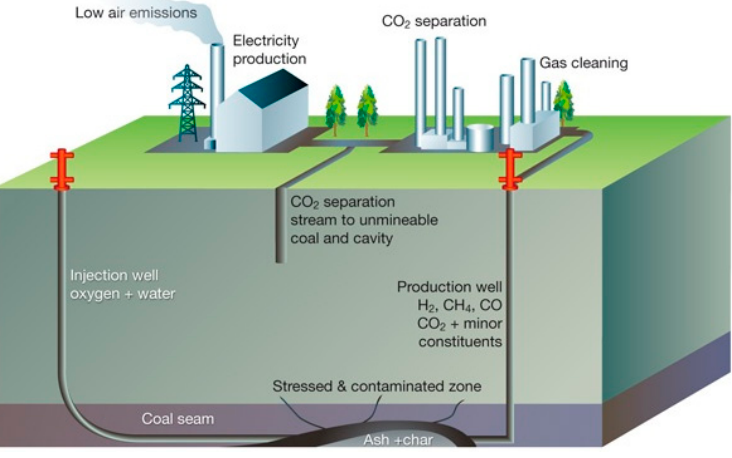
Figure 1. Scheme of UCG technology [22] .